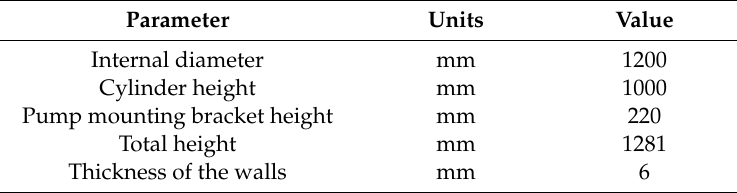
Figure 2. Insulation in the tank and the distribution of temperature sensors.